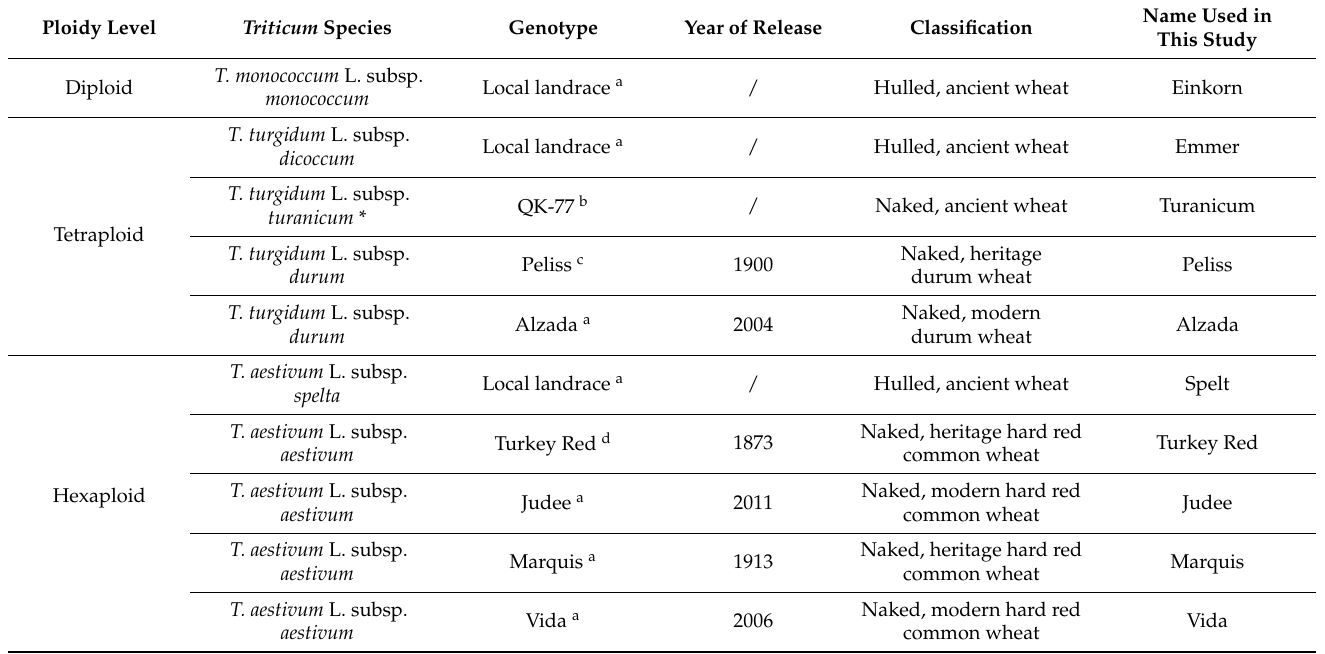
Table 5. List of wheat genotypes used in this study.